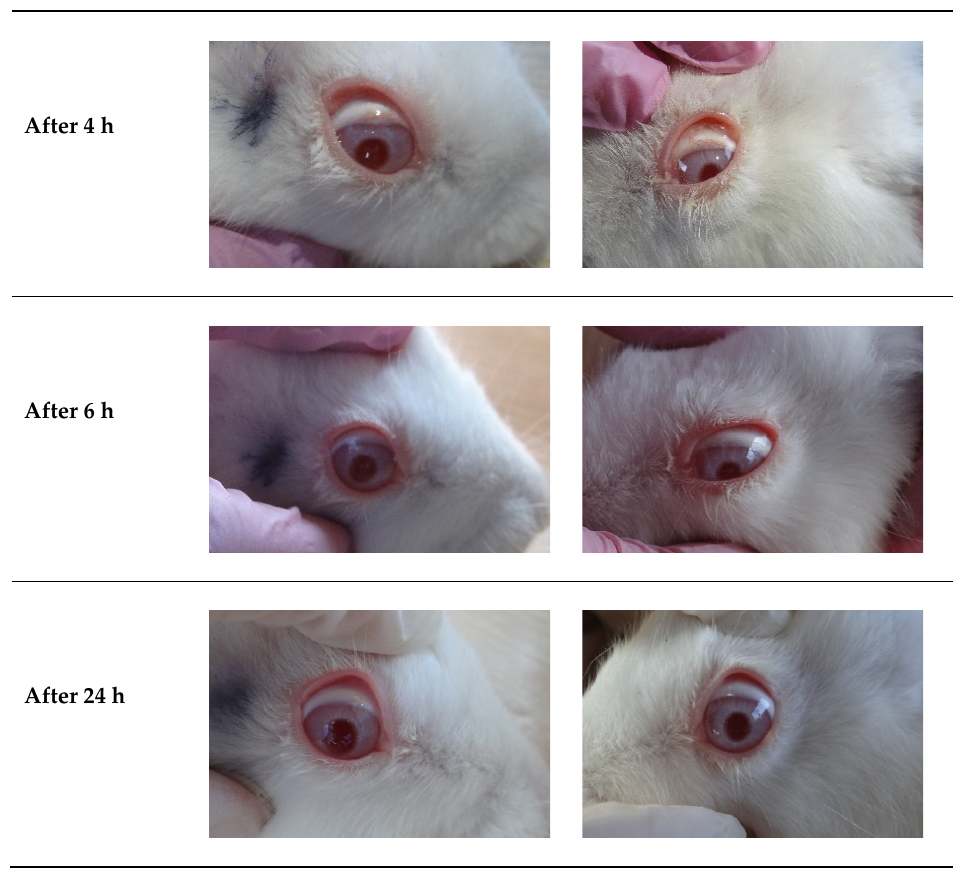
Figure 9. Results of irritation test at different time intervals after the administration of blank and M7 microgel.